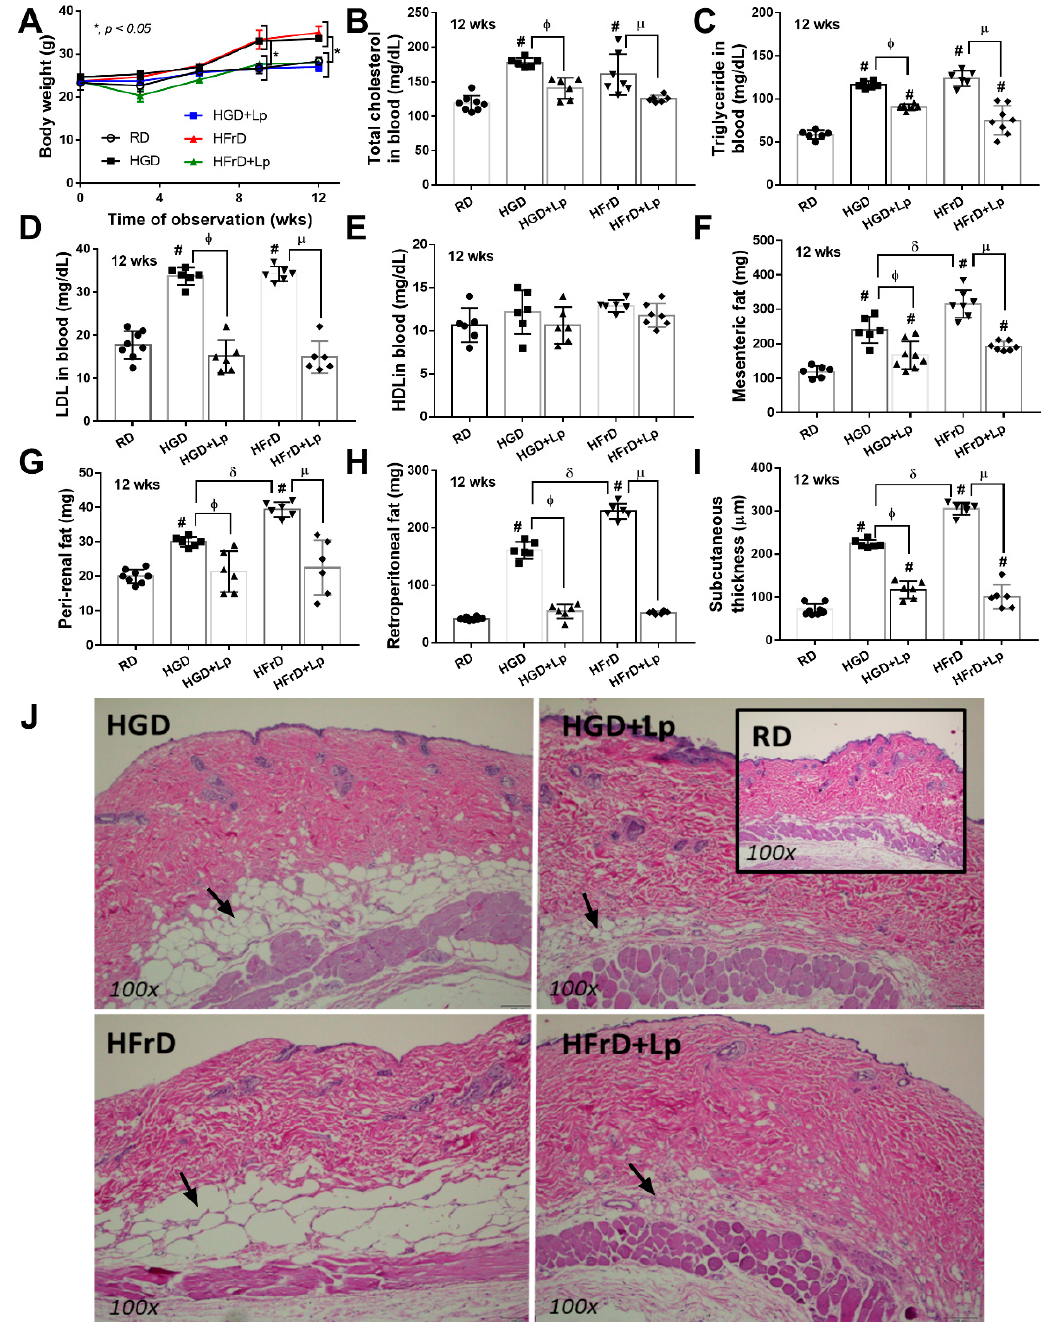
Figure 1. Characteristics of mice with regular diet (RD), or high-glucose diet (HGD), or high-fructose diet (HFrD) with or without Lactiplantibacillus plantarum (Lp) are demonstrated as determined by body weight ( A ), fasting blood lipid profile, including total cholesterol, triglyceride, low density lipoprotein (LDL), and high density lipoprotein (HDL) ( B – E ), adipose tissue depots in several sites ( F – H ), subcutaneous fat thickness ( I ) and representative figures of subcutaneous fat thickness (original magni fi cation 100×) ( J ) are demonstrated (n = 6–8/time point or group). *, p < 0.05 between indi- cated groups; #, p < 0.05 vs. RD; ϕ , p < 0.05 HGD vs. HGD+Lp; µ, p < 0.05 HFrD vs. HFrD+Lp; δ , p < 0.05 HGD vs. HFrD; Arrows indicated subcutaneous fat layers.